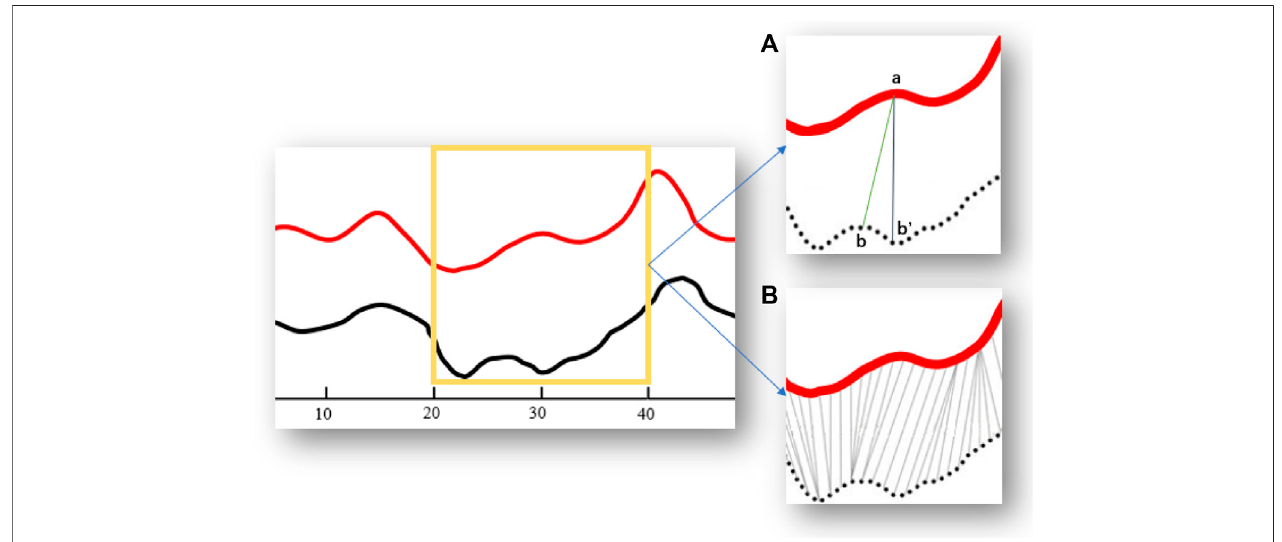
FIGURE 5 | DTW looks for waveform alignment